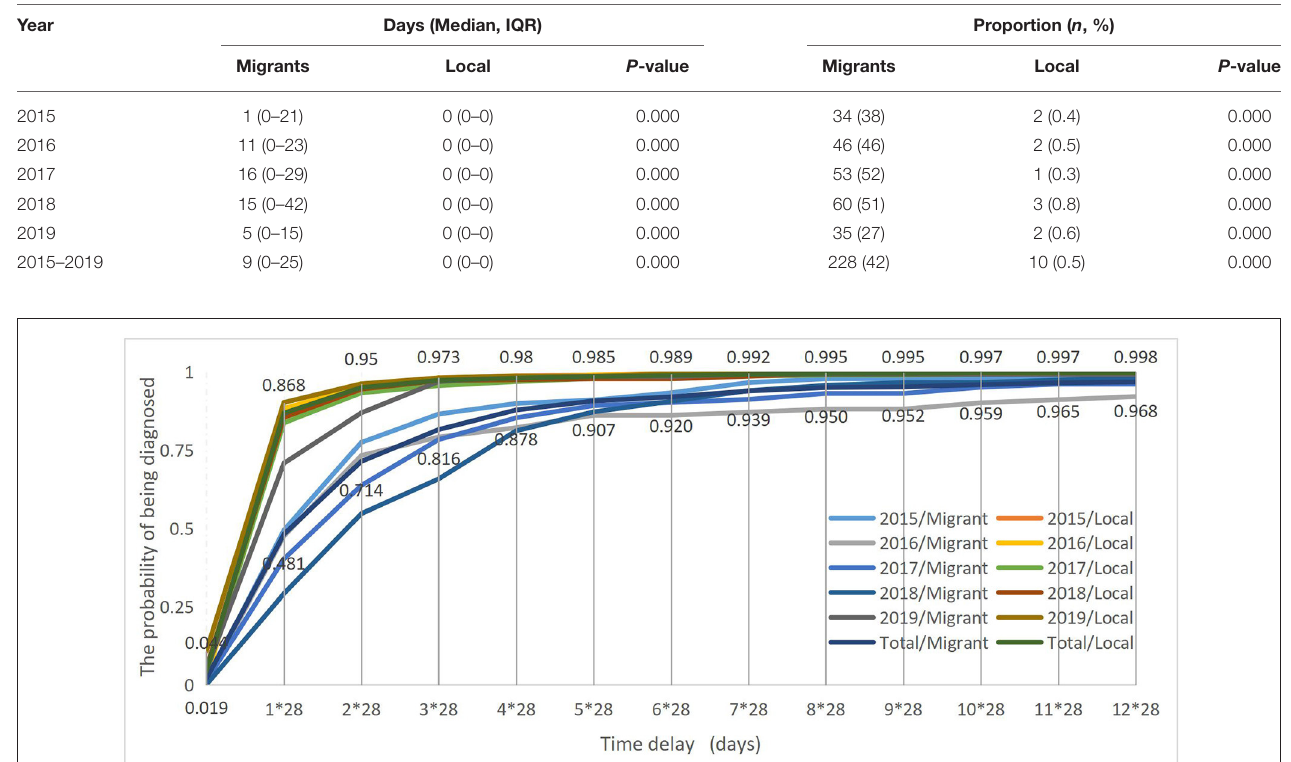
TABLE 4 | Health system delay of migrant and local patients with TB from 2015 to 2019.